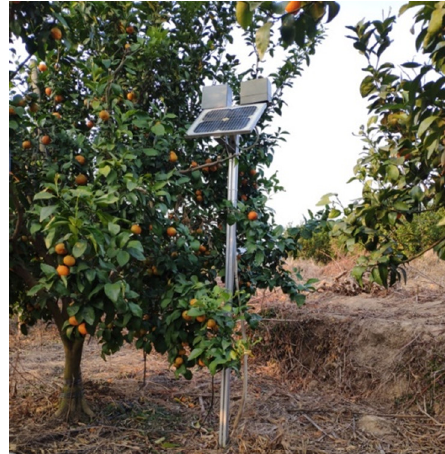
Figure 9. Node set in the citrus orchard.